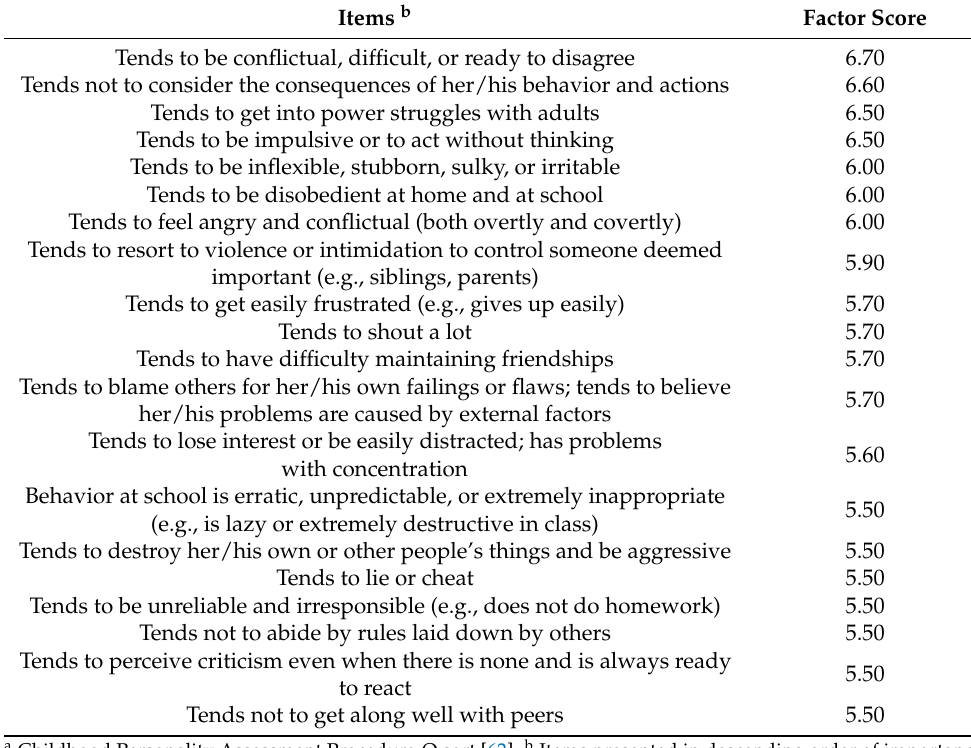
Table 2. Best CPAP-Q a items of the borderline/impulsive prototype.